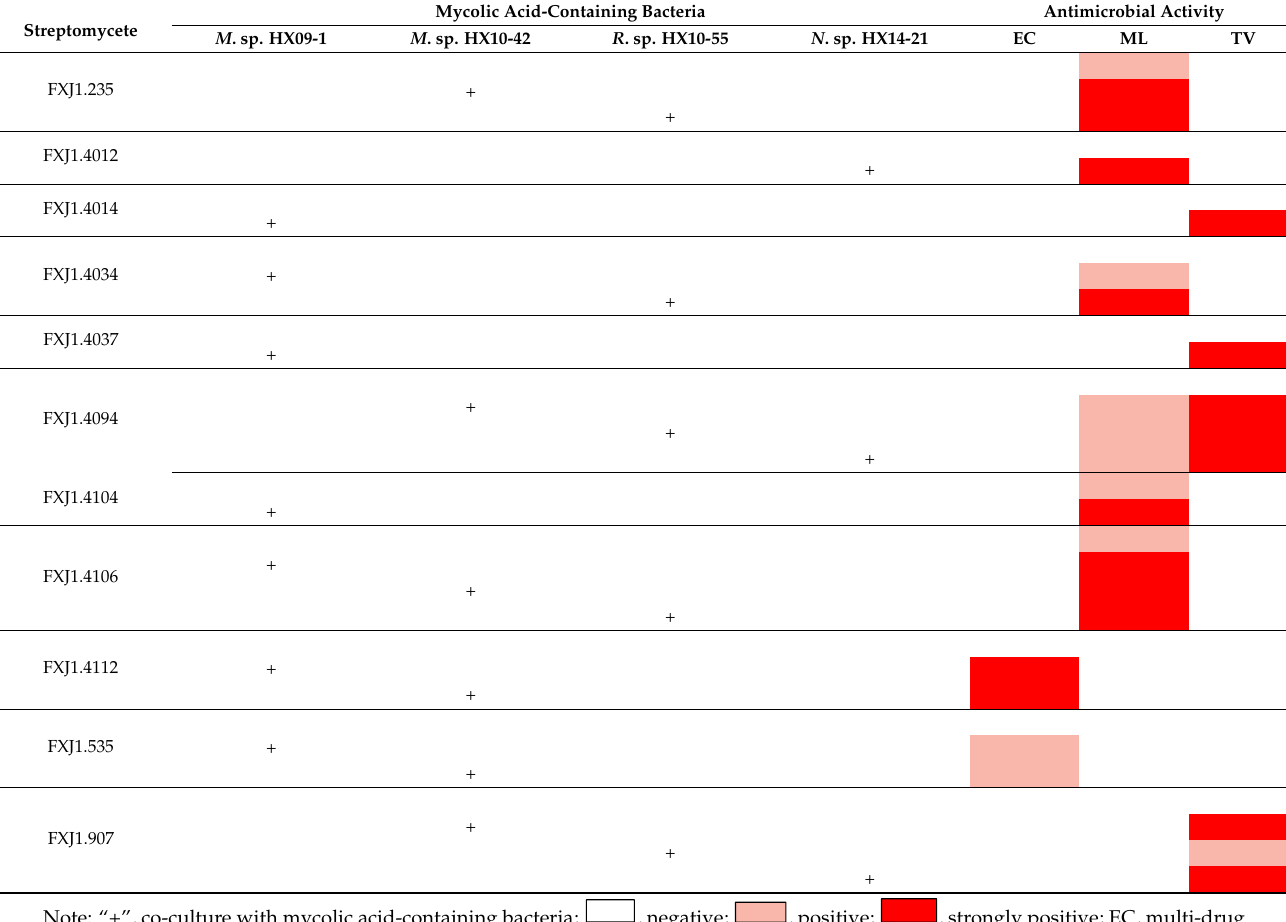
Table 2. Differences of antimicrobial activity between the pure cultures and co-cultures.